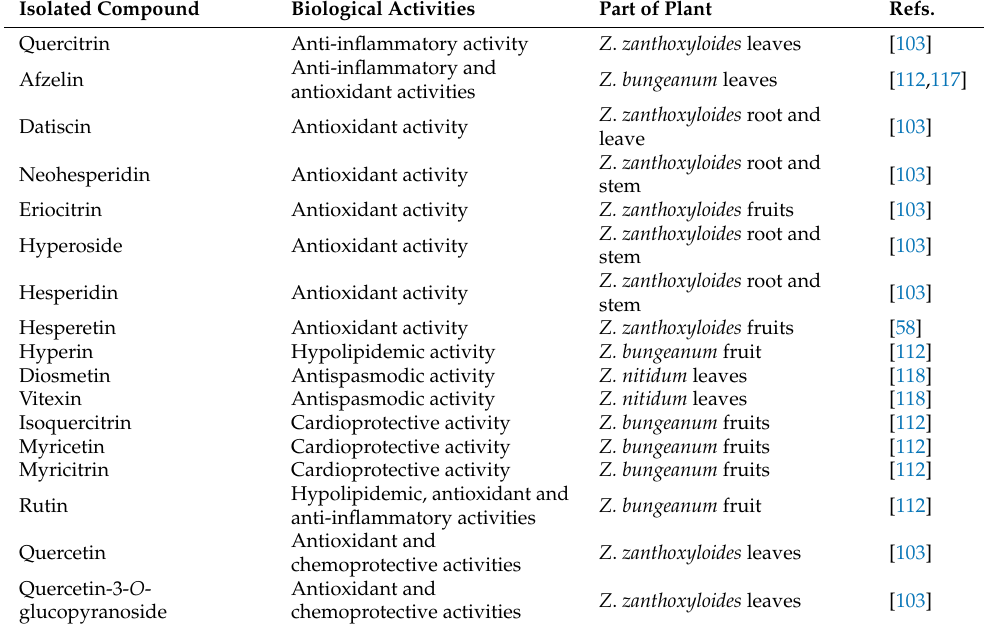
Table 3. Flavonoids and their derivatives isolated from Zanthoxylum species with anti-inflammatory, antioxidant, hypolipidemic, antispasmodic and cardioprotective activities. Isolated